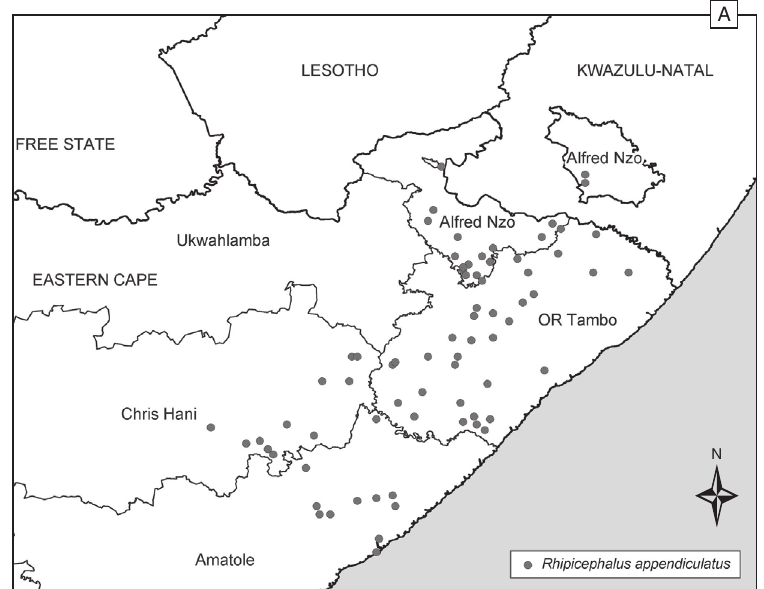
The geographic distribution of Rhip i cephalus append iculatus in (A) the eastern region of the Eastern Cape Province, South Africa and (B) Maputo Province, Mo zambique, and of Rhipi cephalus evertsi evertsi in (C) the east ern region of the Eastern Cape Province and (D)